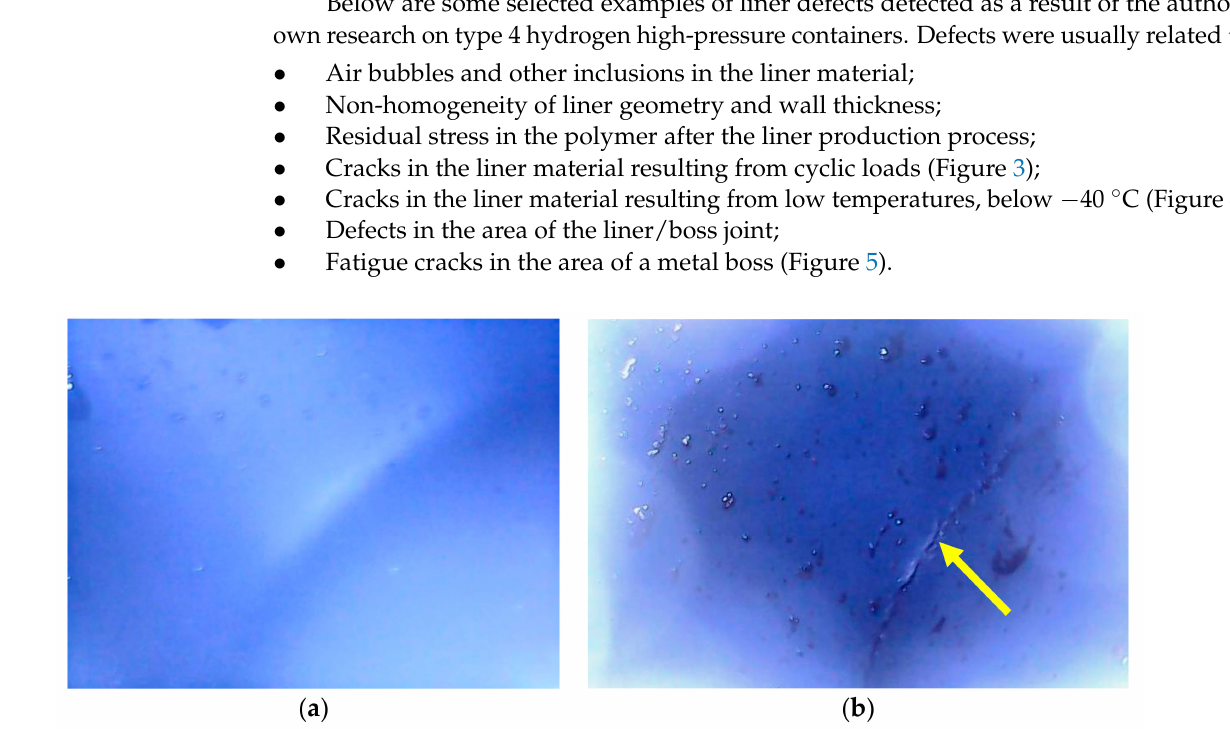
Figure 3. Endoscopy pictures of a defective liner. ( a ) The inlet dome area without visible cracks and ( b ) the outlet dome area with cracks around the boss–dome interface (marked by an arrow).